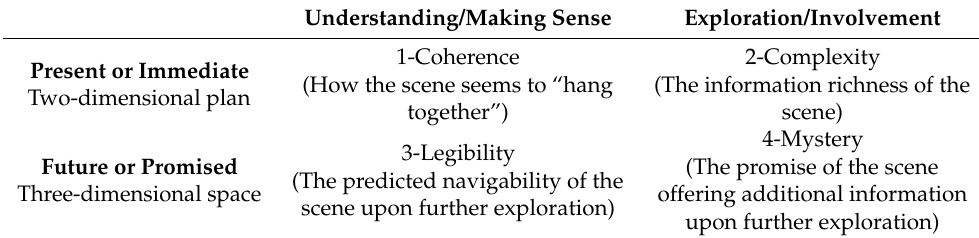
Table 1. The framework of Kaplan information processing